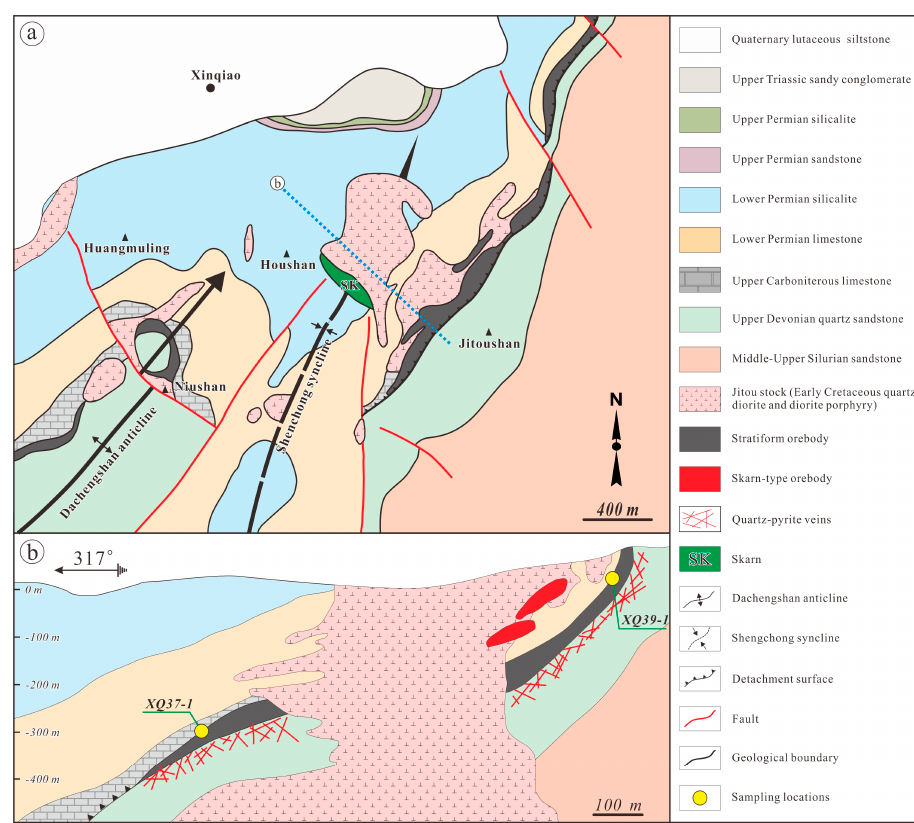
Figure 3. ( a ) Geological map and ( b ) representative cross section of the Xinqiao Cu–S–Fe–Au deposit (after [44,51], respectively).